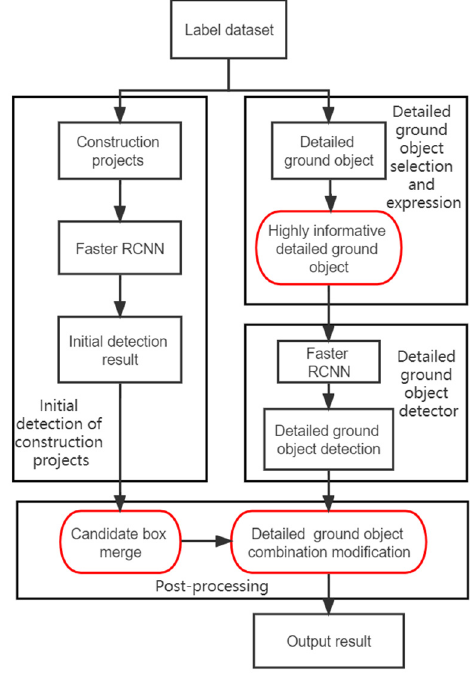
Figure 1. The method flow chart.